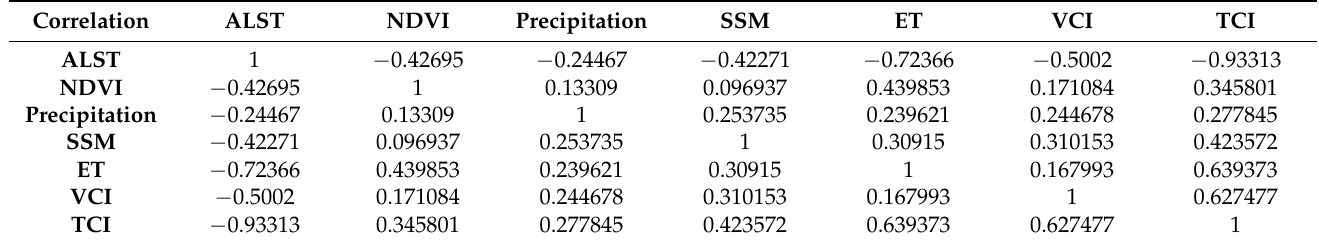
Table 8. Correlation between effective environmental factors of Sarbaz